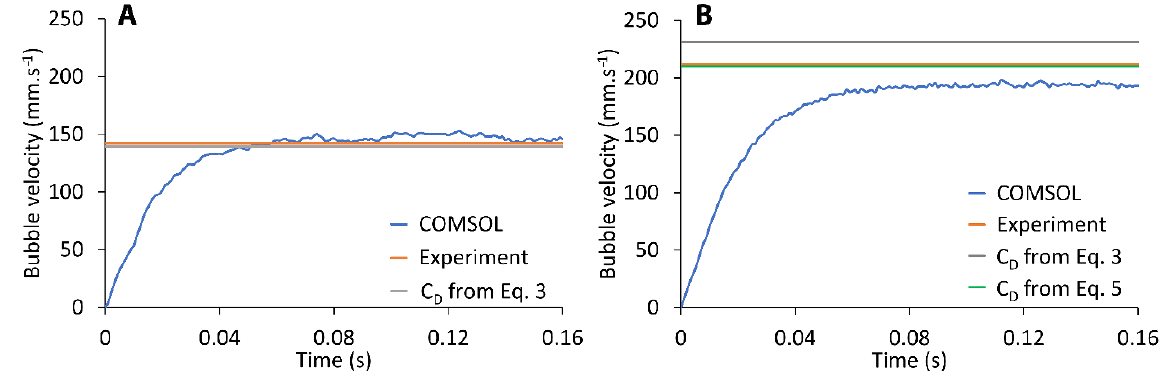
Figure 2. ( A ) Time-dependent velocity of a 0.6 mm bubble rising in pure propanol, compared to steady-state experimental value and theoretical computed using the Mei drag coefficient correlation (Equation (3)) for a spherical bubble ( B ). Time- dependent velocity of a 0.8 mm bubble rising in pure propanol, compared to steady-state theoretical value computed using Moore expression (Equation (5)) for a deformed bubble.